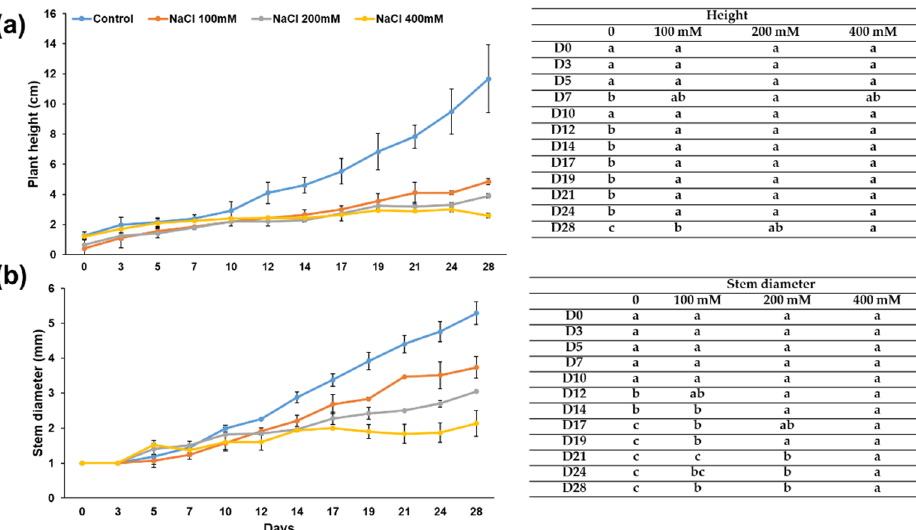
Figure 1. Impact of increasing concentrations of NaCl on Micro-Tom from day 0 to day 28. ( a ) Plant height and ( b ) stem thickness. Tables on the right-hand side: statistical significance of the data shown in Figure 1. Different letters denote statistically different values among groups at the ANOVA one-way with Tukey’s post-hoc test. “D”refers to days. A compact letter display [26] is used to indicate the significance between groups of samples. For height: D0 [F(3,5) = 2.45, p = 0.179], D3 [F(3,5) = 1.62, p = 0.296], D5 [F(3,5) = 4.87, p = 0.061], D7 [F(3,5) = 7.35, p = 0.028], D10 [F(3,5) = 2.55, p = 0.169],